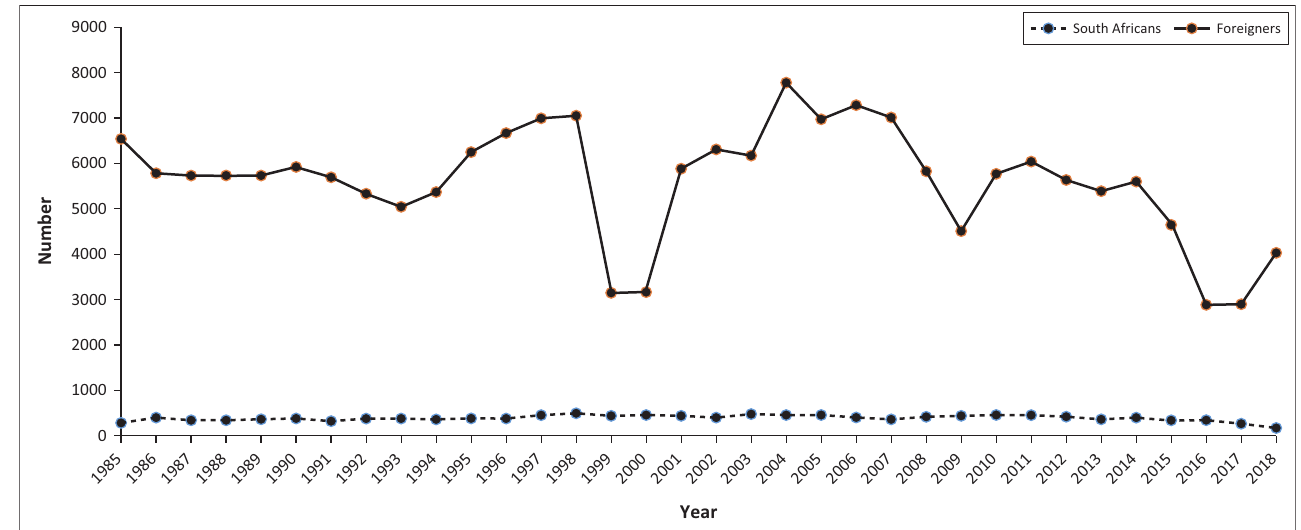
FIGURE 2 : Patent applications at the Companies and Intellectual Property